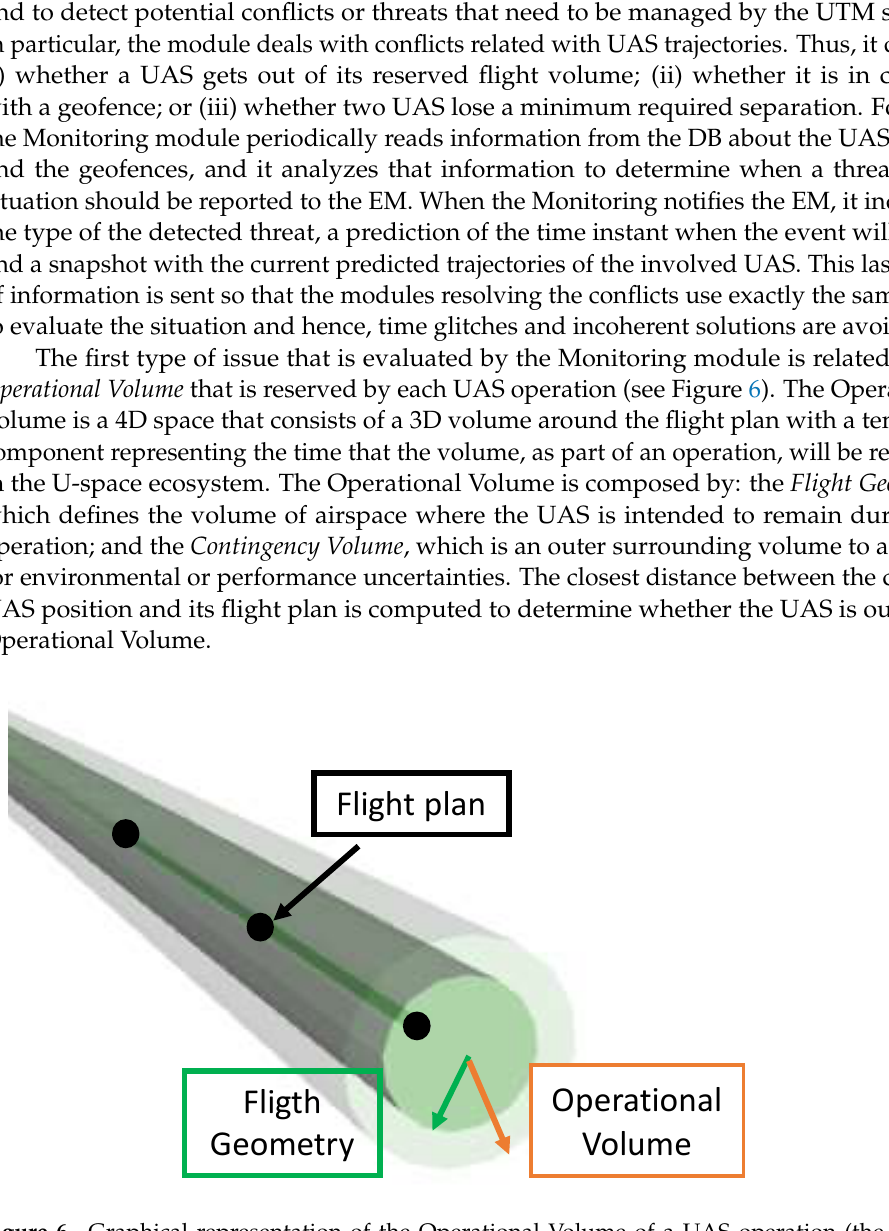
Figure 6. Graphical representation of the Operational Volume of a UAS operation (the orange arrow represents its radius). Given a flight plan, the green cylindrical volume around would represent its Flight Geometry (the green arrow indicates its radius), whereas the outer volume is the Contingency